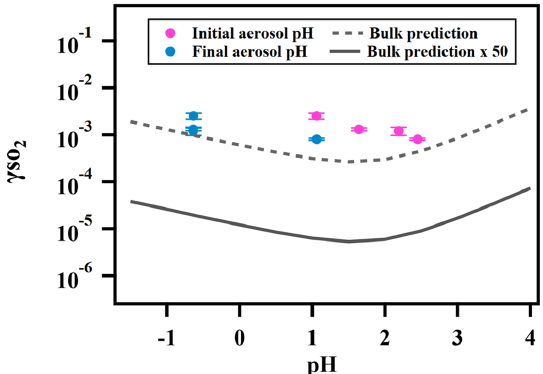
Figure 5. Relationship between γ SO monium sulfate aerosol containing 2-butanone